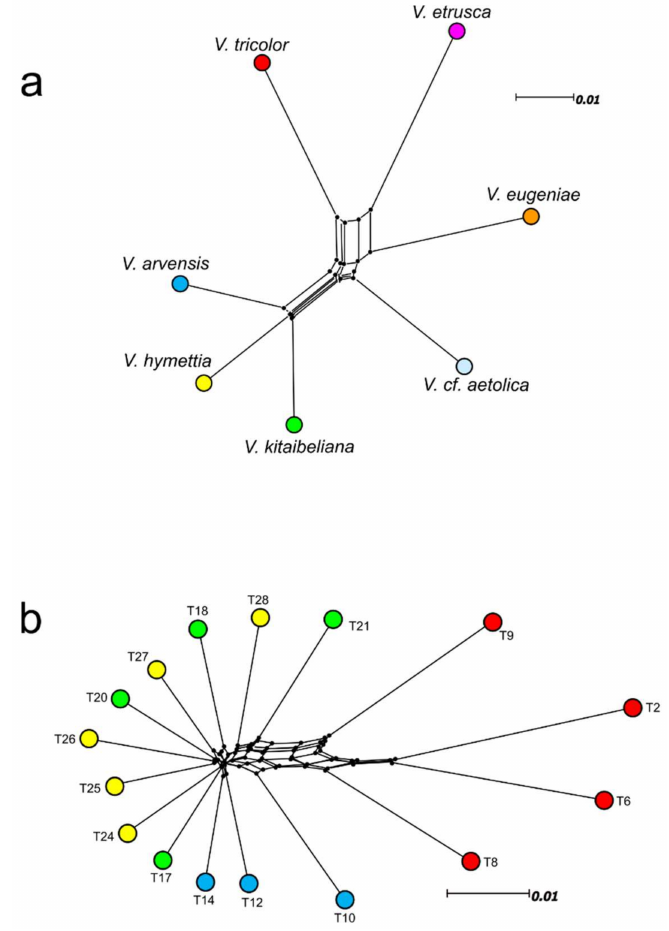
Figure 3. Neighbor-Net splits graph generated with the 5S-IGS sequences filtered for abundance ( ≥ 25) and length ( ≥ 280 bp) in all investigated species ( a ), and all samples belonging to the ‘ V. tricolor species complex’ ( b